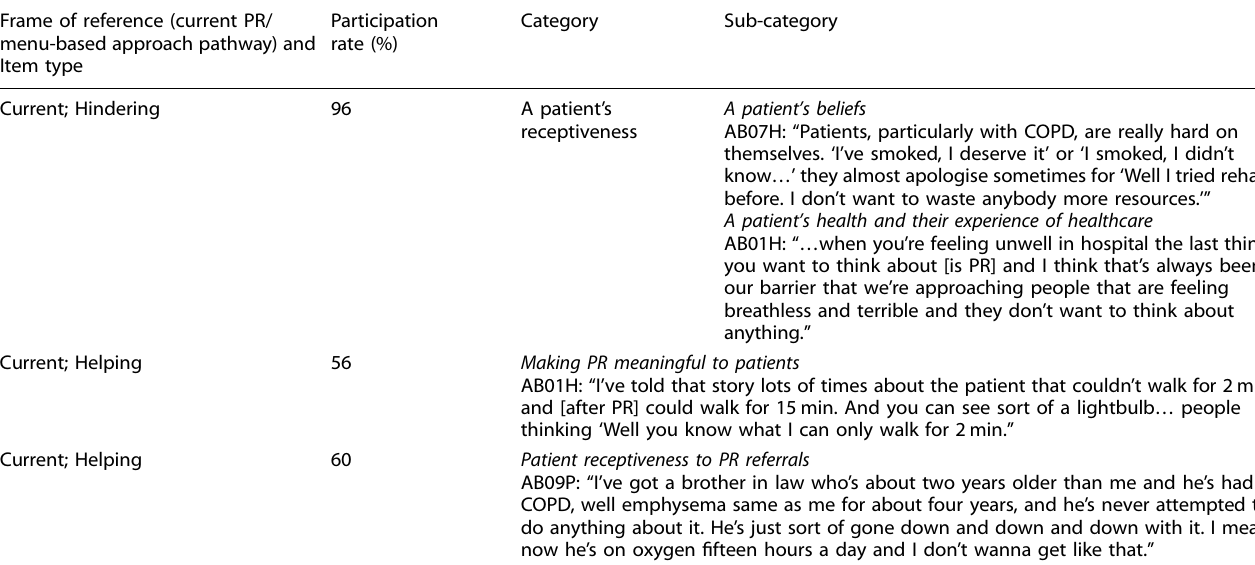
Table 5. A desire to accept PR. Frame of reference (current PR/ menu-based approach pathway)